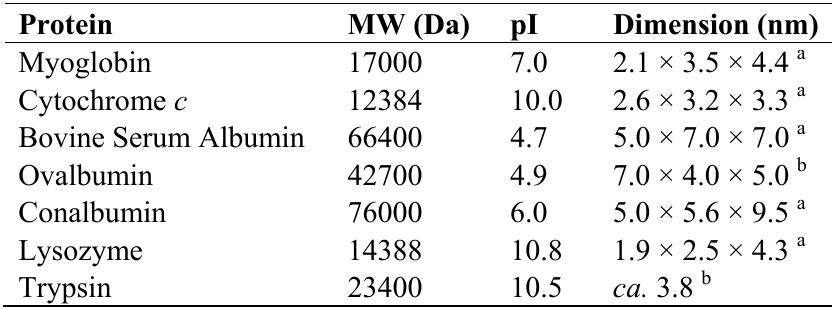
Table 1. Molecular weight (MW), isoelectric point (pI)and size of model proteins used for “in mesopore”